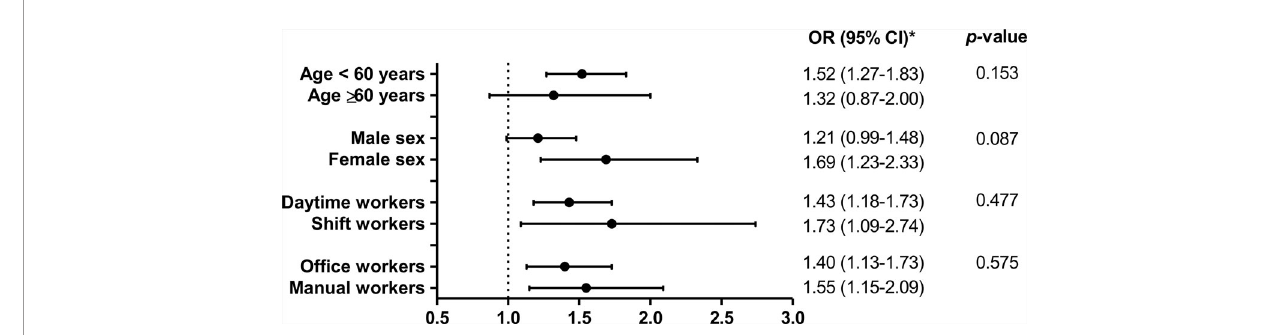
FIGURE 2 | Association between working hours and NAFLD in subgroup analysis. *ORs for NAFLD in subjects working 53 – 83 hours/week in reference to those working the standard 36 – 42 hours/week are presented with 95%